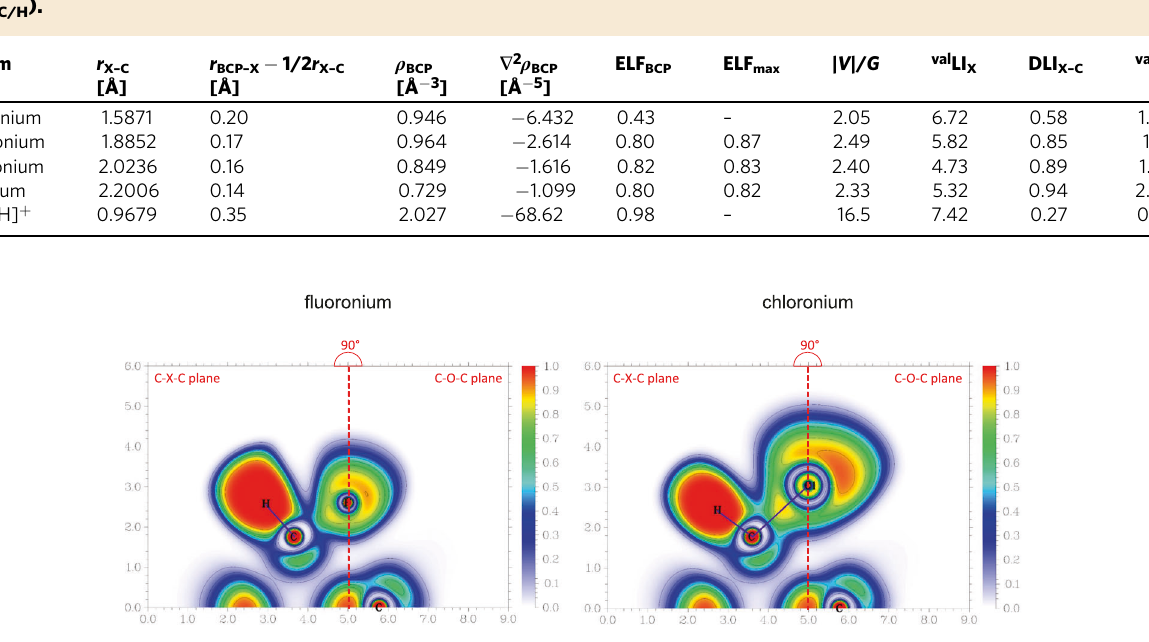
Fig. 4 Electron localization in Fluoro- and Chloronium. Electron localization function in the C – X – C plane (X = F, Cl) of 1 (left) and its chloronium analog (right) and in their C – O – C planes containing the halogen ’ s lone pairs, perpendicular to the former one. Both planes are merged at the molecule ’ s O – X axis (dashed red line). ELF is de fi ned from 0.0 (white) to 1.0 (red); contours are drawn in intervals of